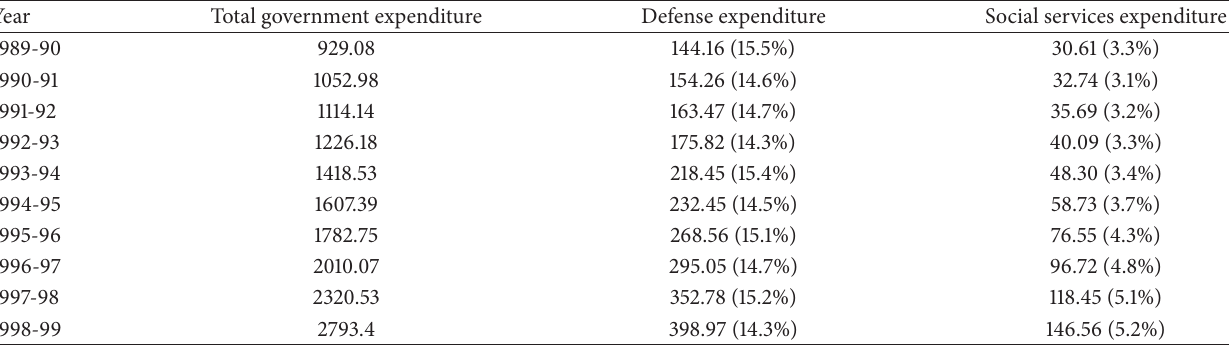
Table 16: India’s total government expenditure and expenditure on social services (including health) and defense during the economic crisis of early 1990s (in billion current